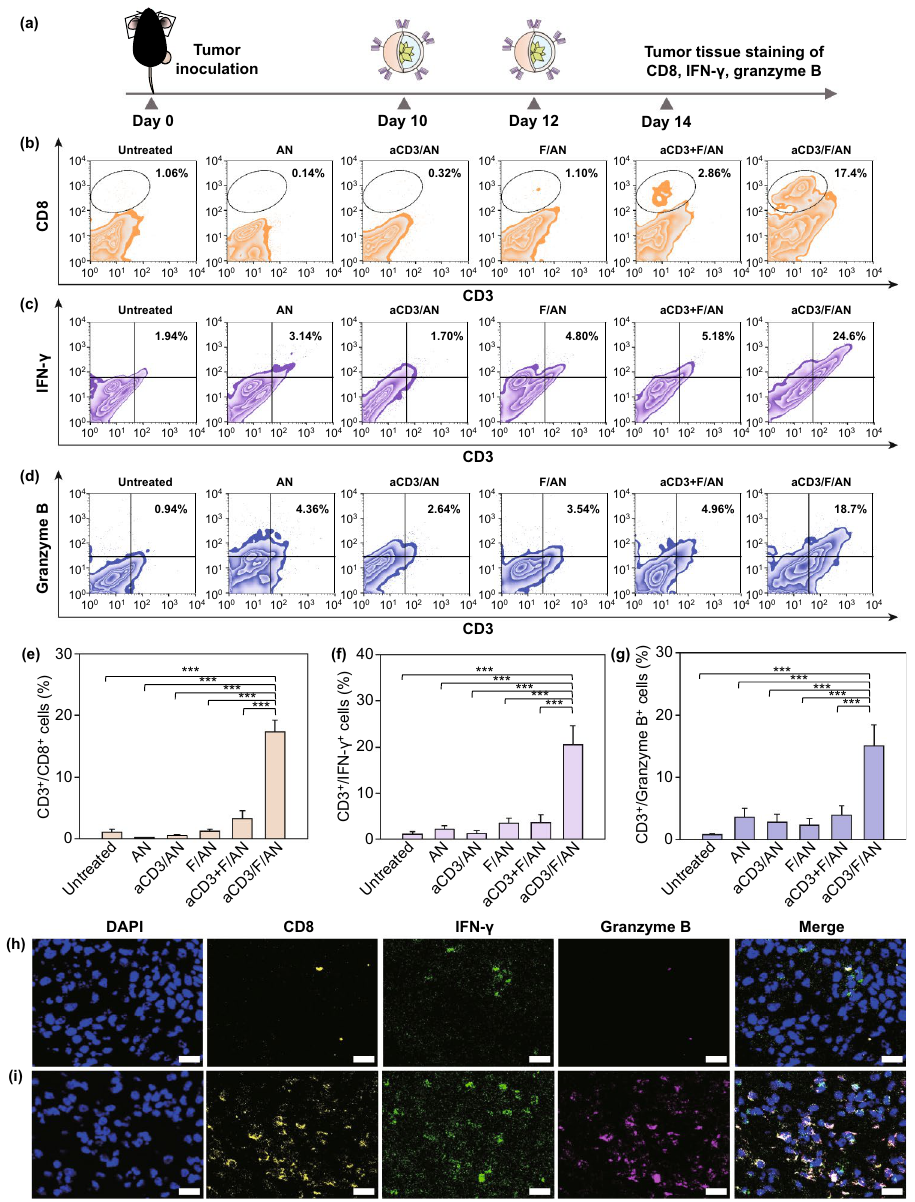
Fig. 11 In vivo cytokine production by T cells in tumor tissues. a B16F10 tumor‑bearing mice were injected with nanoparticle preparations on days 10 and 12 after tumor inoculation. On day 14, tumor tissues were extracted for analysis. b‑d Infiltrating CD8 + T cells ( b ), IFN‑γ–expressing T cells ( c ) and granzyme B–expressing T cells ( d ) among tumor tissue CD3 + T cells, determined by flow cytometry (***P < 0.001). Populations of CD3 + /CD8 + cells ( e) , CD3 + / IFN‑γ + cells ( f) and CD3 + /granzyme + cells ( g) are shown. h, i In untreated ( h ), and aCD3/F/AN‑treated mice ( i ), tumor tissues were extracted and immunostained with anti‑CD8 (yellow), anti‑IFN‑γ (green) and anti‑granzyme B (light purple) antibodies and counterstained with DAPI. Scale bar: 20